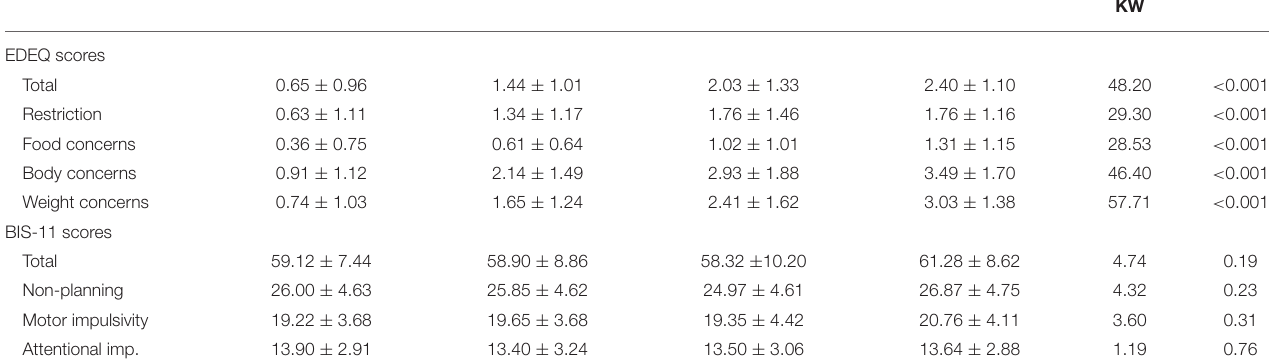
Normal Preobese/Overweight ( n :40) ( n :40)